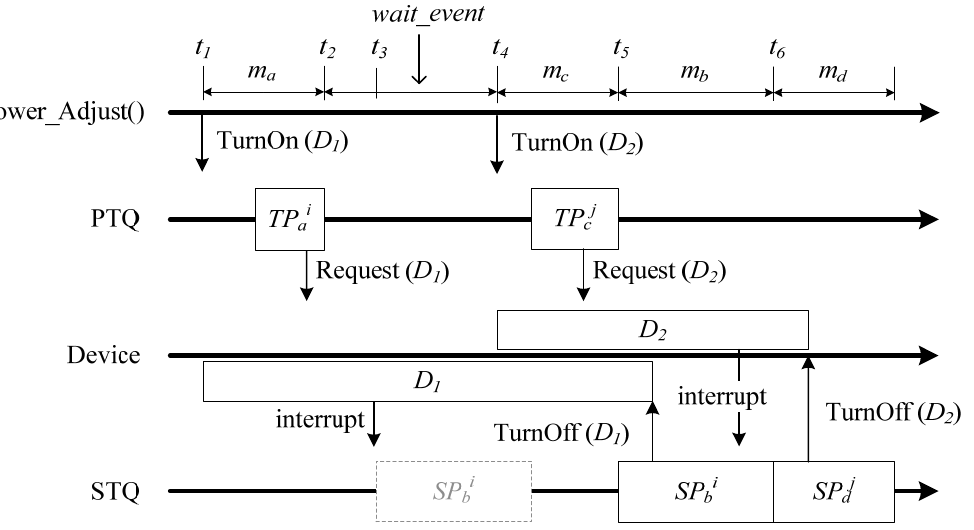
Figure 5. Power mode transition scenario when there is an overlap of